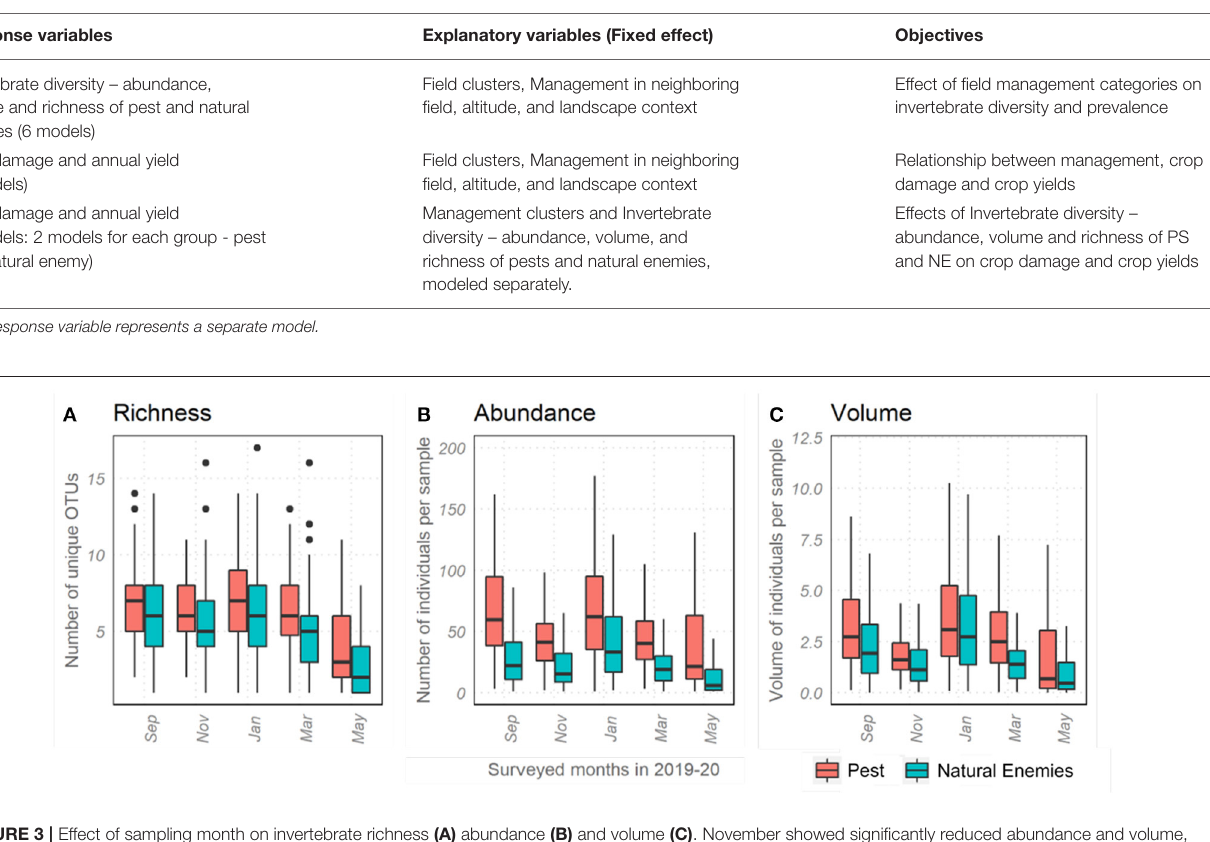
response variables and richness, abundance and volume of pest and natural enemies as